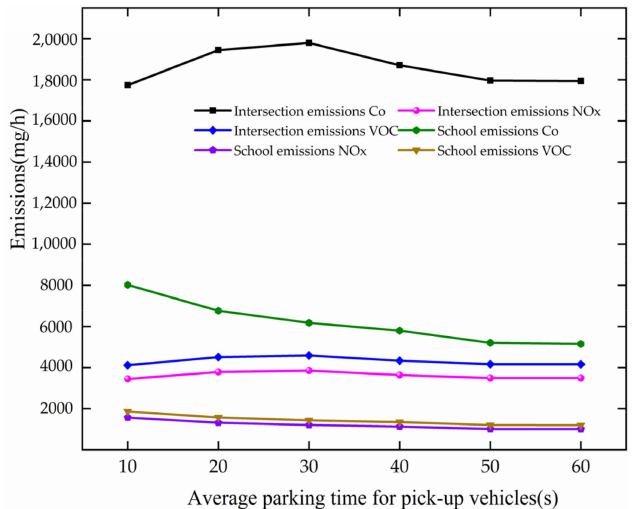
Figure 32. Variation trend of pollutant gas emission with